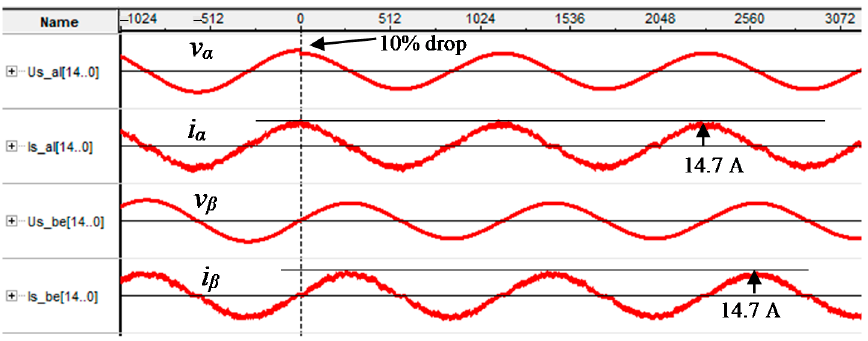
Figure 18. The 10% voltage drop at constant active component 0.7 P N .